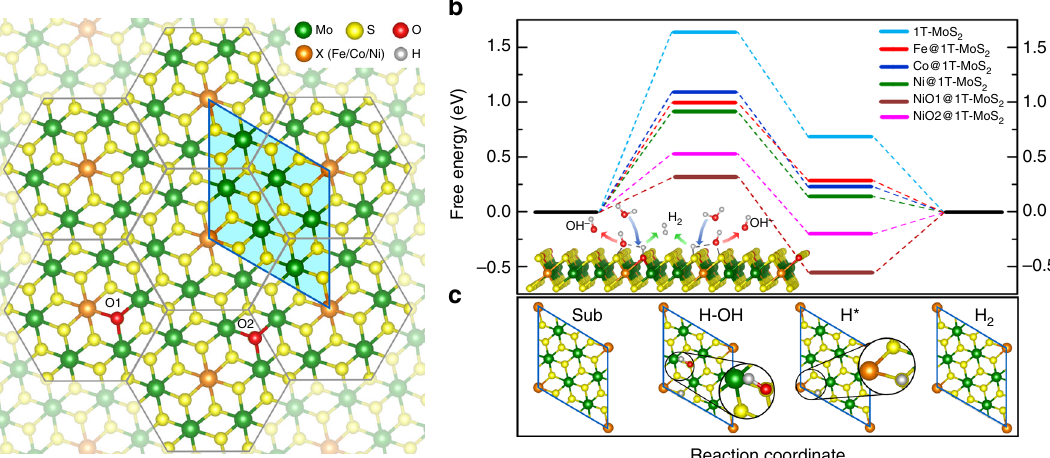
Fig. 6 First-principles calculations of the doping effect on HER performance. a The monolayer structure of XO@1T-MoS 2 formed by the XMo 6 hexagon motifs codoped by O. b Free energy diagrams on the surface of different catalysts in alkaline solution, with the smallest repeating unit cell used in calculations indicated in a . c The structures of predicted intermediates that bind to water and hydrogen. The green, yellow, orange and red spheres represent Mo, S, X (Fe, Co, Ni) and O atoms,